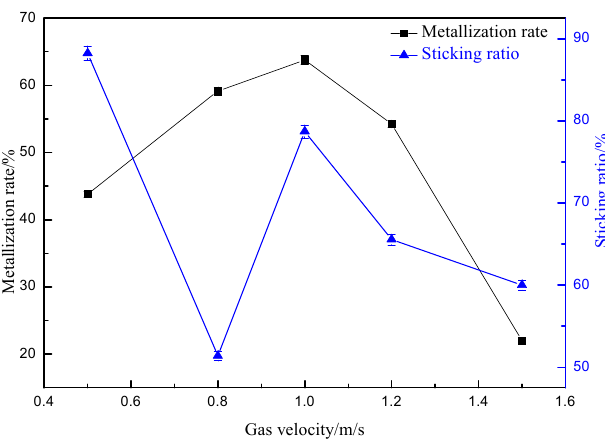
Figure 3. Trend of the metallization rate and sticking ratio with changing linear velocity when 0.18 mm–0.66 mm of OMC fine iron ore is reduced by pure carbon monoxide at 0.2 MPa, 1023 K after 50 min.